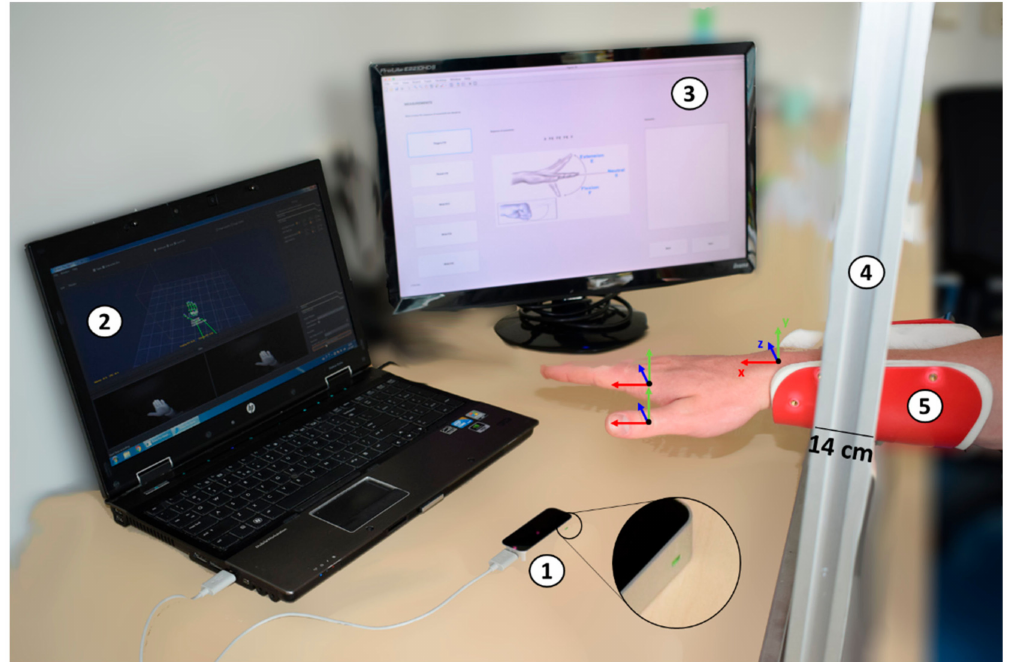
Figure 1. Experimental setup. (1) The controller of the Leap sensor. The green light indicates that the controller is on. (2) Brekel Pro Hands application in real-time, on the host computer. (3) The Guide User Interface shows which movement the participant should do. (4) The platform with (5) arm support at a distance of 14 cm from the table’s surface, where the participant should place his